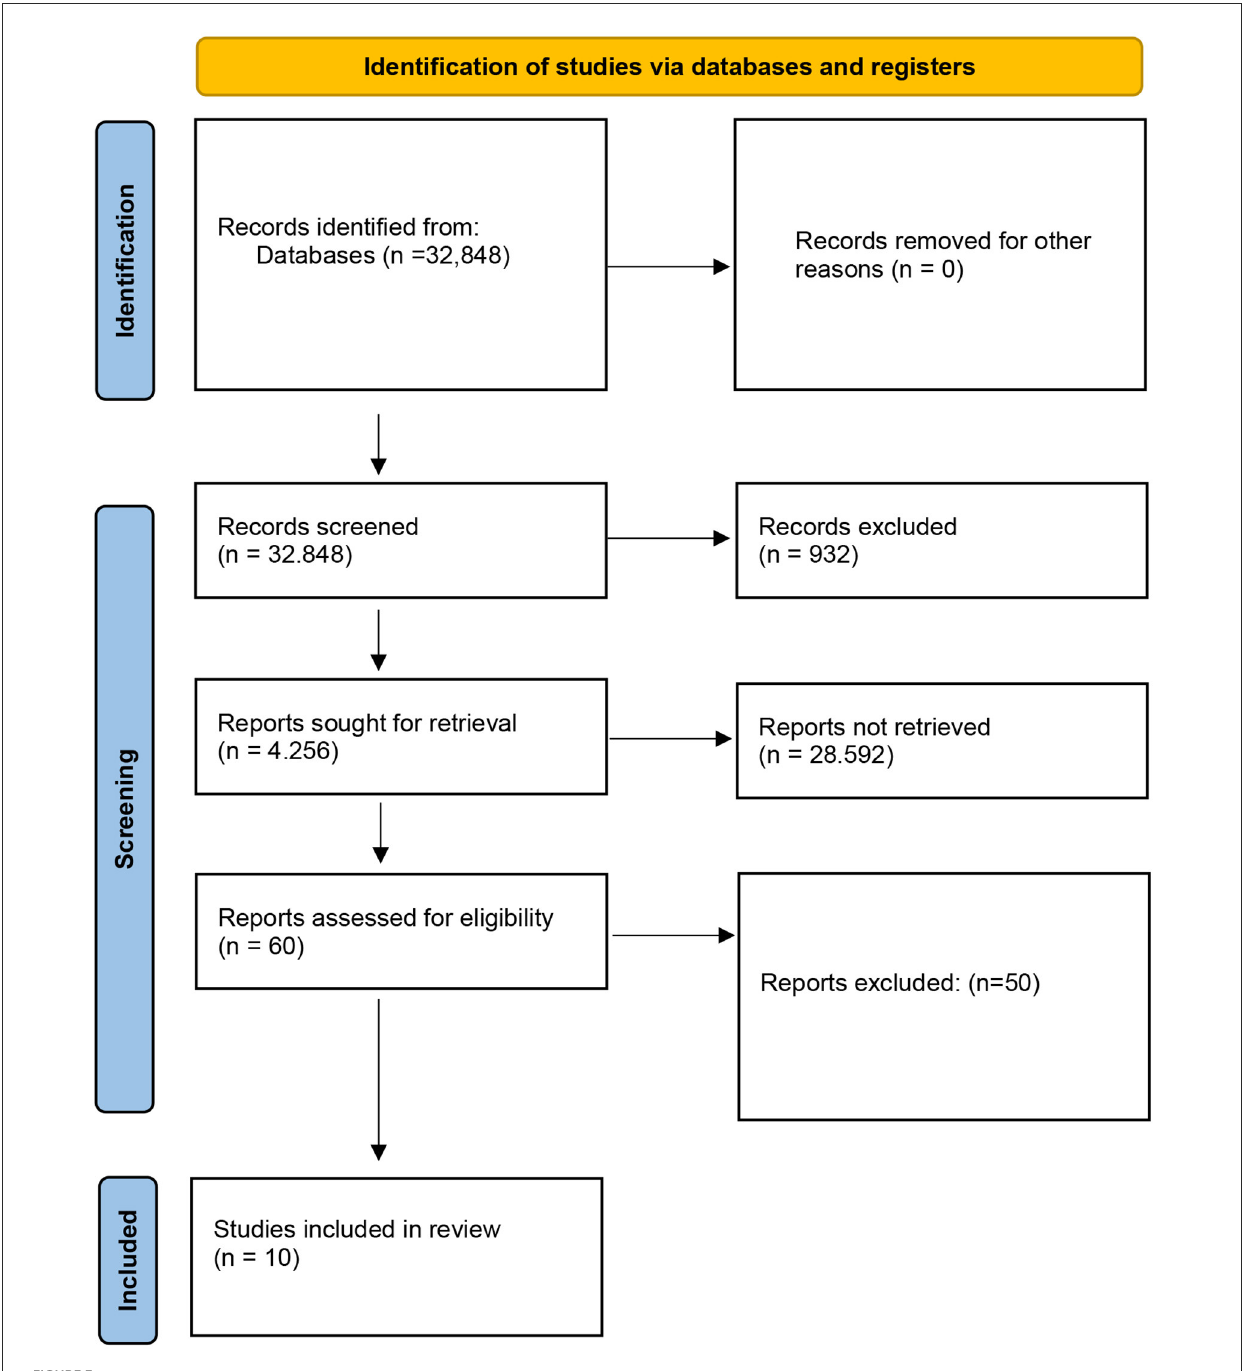
FIGURE3 PRISMA flow chart. Source: Own